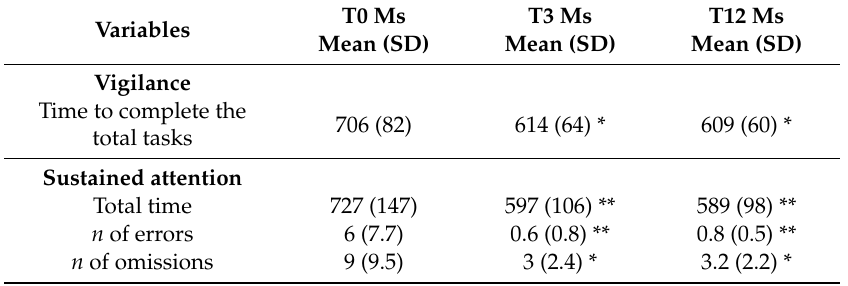
Table 5. Results of the Test of Attentional Performance (TAP test) before and on LNAAs